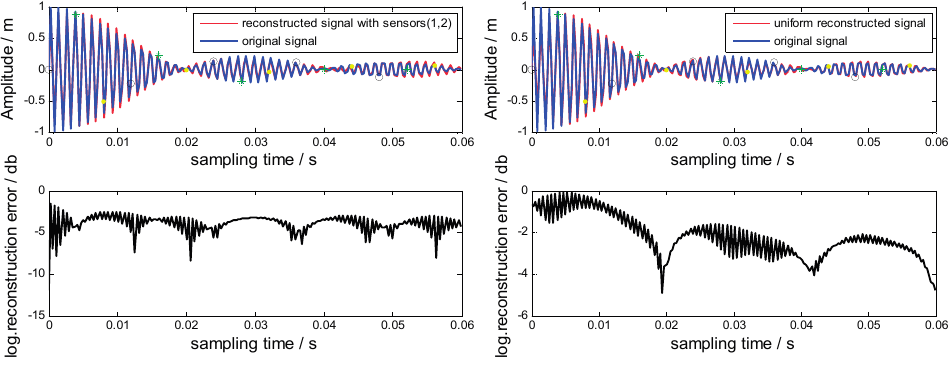
Figure 7. Reconstructed signals and local logarithmic reconstruction